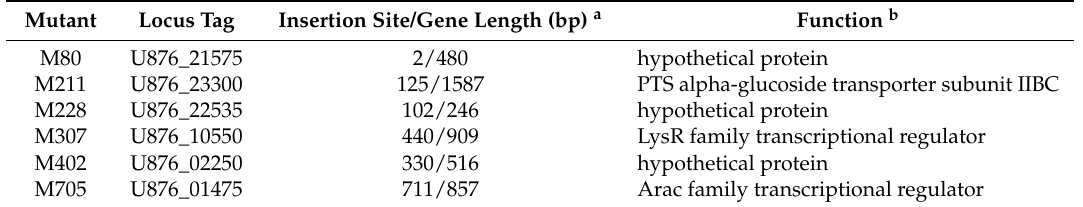
Table 1. Characteristics of the hemolysis-reduced mutants screened by transposon mutant library. Mutant Locus